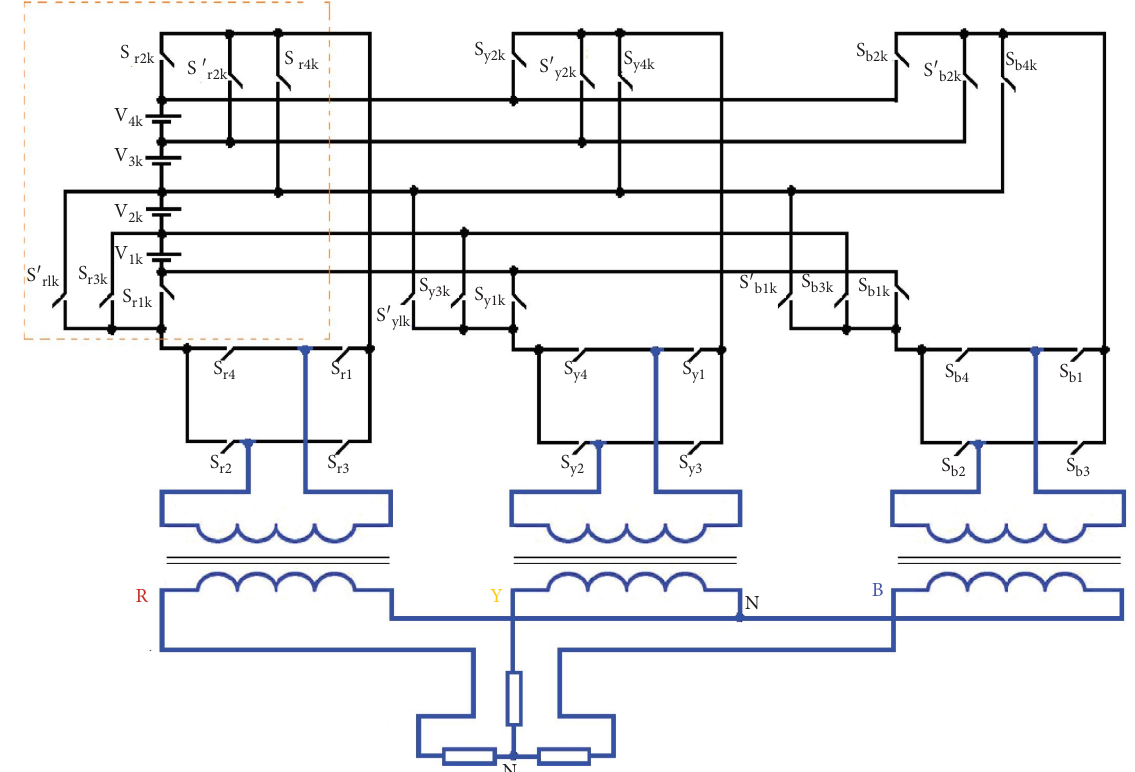
Figure 2: Proposed three-phase voltage levels. Table 2 tabulates comparison between the proposed three-phase topology and conventional topologies.